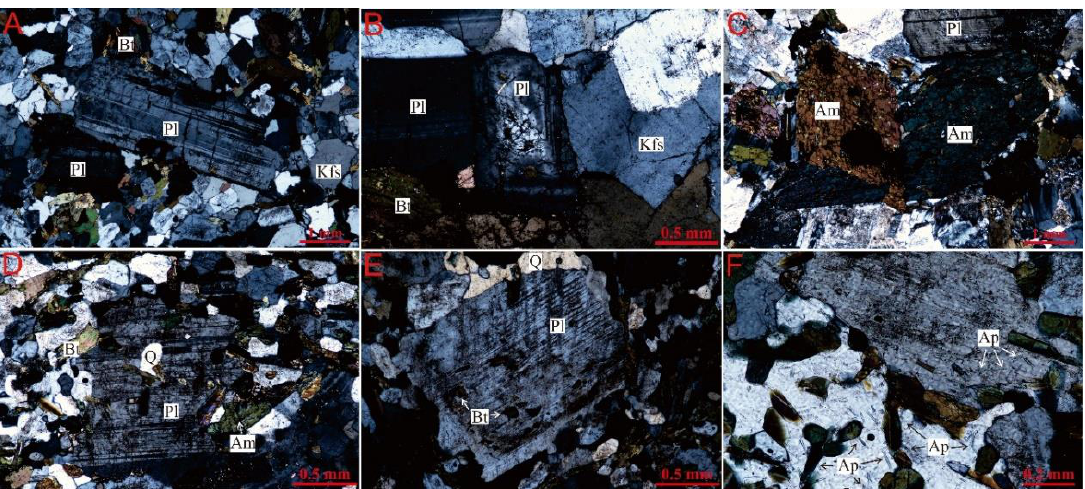
Figure 2. ( A,B ) Field occurrence of the mafic enclaves in the Qingshanbao complex of the Longshou Mountain.